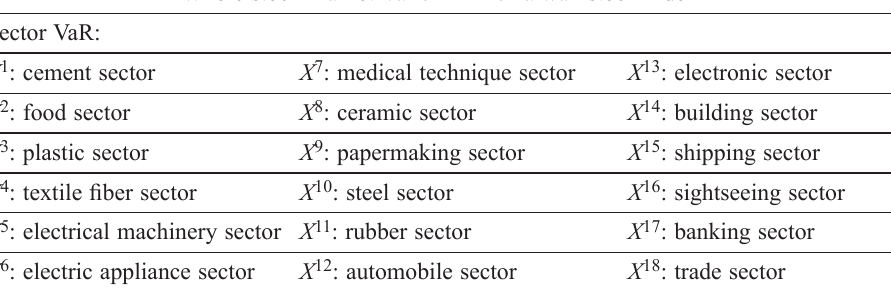
Table 1. Variable de fi